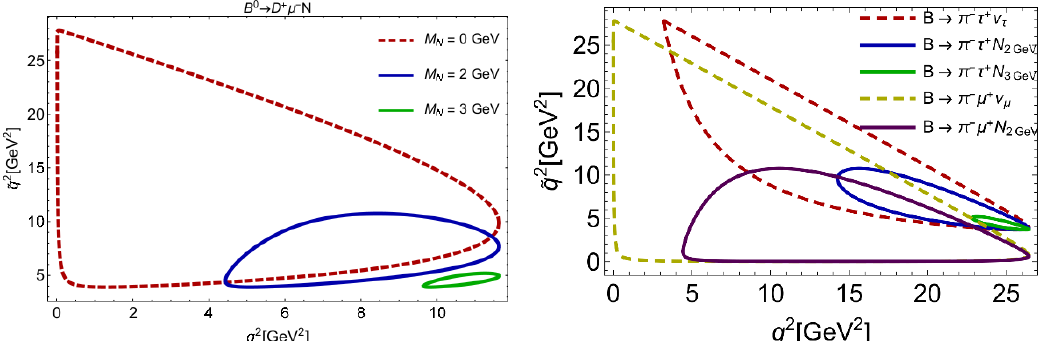
Figure 6 . Dalitz plot for the semileptonic decay B 0 drastically when HNL mass is large. q 2 is the invariant mass of the lepton pair, ~ q 2 is the invariant mass of the (cid:12)nal meson and charged